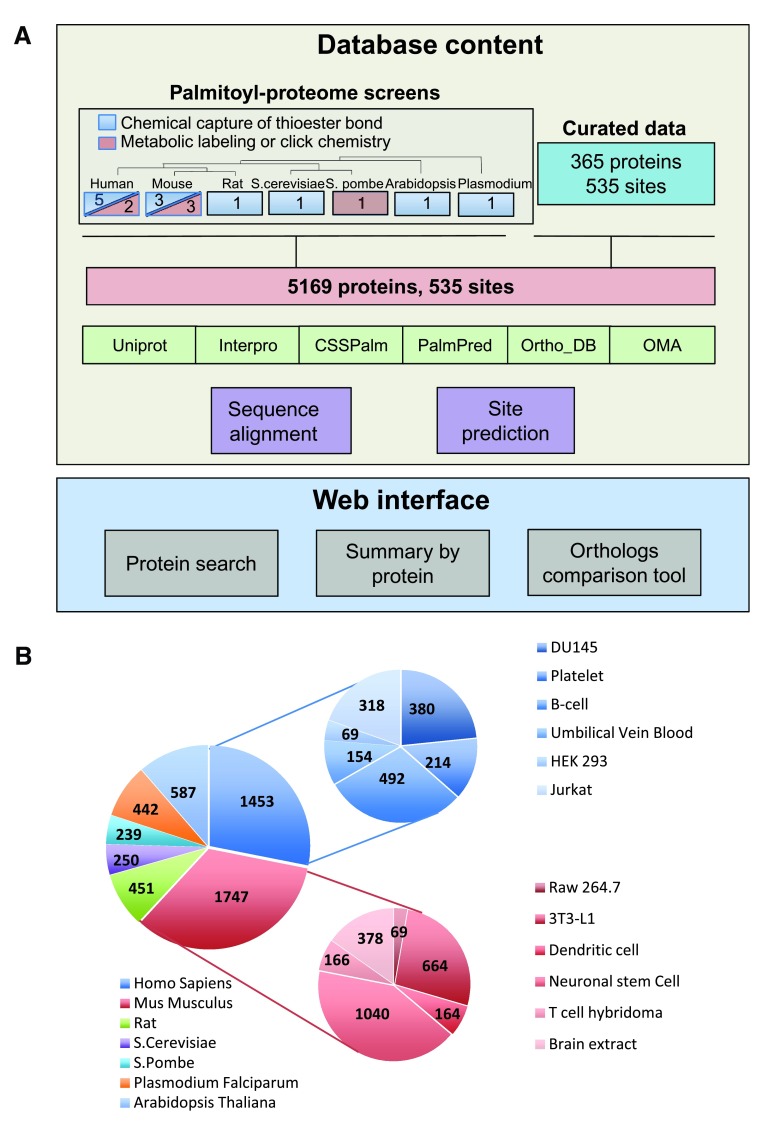
Palmitoyl-proteomes integrated in SwissPalm.
A: Database content: Primary data on S-palmitoylation of proteins are extracted from MS large scale experiments on different species. Curated data on S-palmitoylation are obtained from the literature and input together with the MS information in the same data structure. In order to perform complex query related to S-palmitoylation, we have integrated in the database various external sources like orthology databases (Ortho_DB and OMA), UniProt features and subcellular localization information and Interpro domains. We ran also programs to have additional data, like multiple alignments of orthologous proteins or protein isoforms, and results from existing S-palmitoylation site predictors (CSS-Palm 4.0 and PalmPred). Web interface: The web interface presents the knowledge on S-palmitoylation in protein-centric pages. These pages are accessible through queries on a search engine. Some tools to analyse S-palmitoylation datasets are available online, like the orthologs comparison tool, aiming to perform cross-species S-palmitoylation comparison.
B: 19 palmitoyl-proteomes from 7 species and various cell types and tissues were selected from published literature and integrated to SwissPalm. In total the dataset includes 5199 proteins.